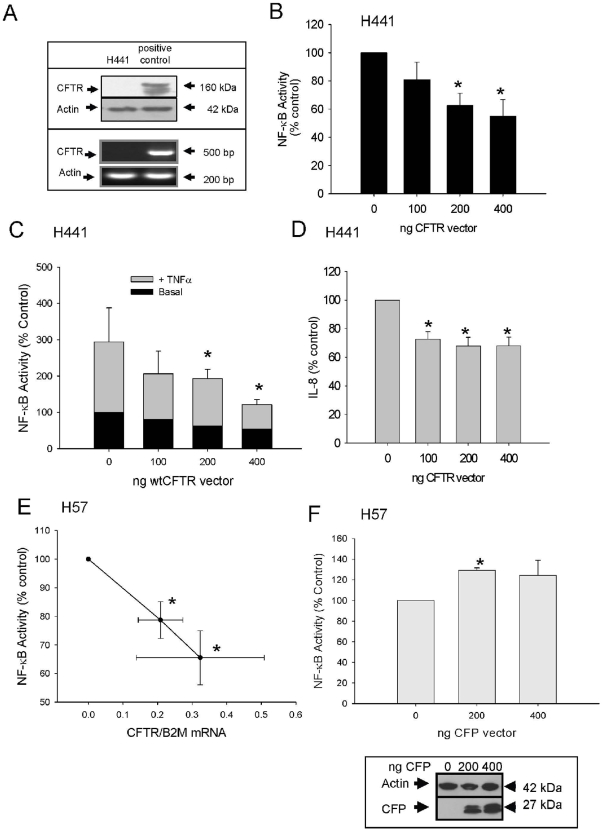
Wild-type CFTR attenuates both basal and induced inflammation.
A. H441 cells do not express CFTR protein as shown by western blot or CFTR mRNA as shown by RT-PCR (representative of 3 experiments). B. NF-κB activity in H441 cells transfected with increasing amounts of wt CFTR cDNA (0–400 ng, n = 5, *p<0.01). C. NF-κB activity in H441 cells transfected with increasing amounts of wt CFTR and treated with 10ng TNFα for 4 hours (open bars, n = 5, * p<0.001). Closed bars represent basal levels of activity re-drawn from figure 1B. D. The levels of IL-8 in the supernatants from B were measured by the ELISA method, n = 3, * p<0.01. E NF-κB activity (y-axis) in H57 cells transfected with increasing amounts of wt CFTR cDNA (0–400 ng), n = 5, *p<0.05. The amount of CFTR mRNA was then analysed by real-time PCR (qPCR) (x axis). There was no CFTR mRNA detected in the H57 cells prior to transfection, thus these treatments were allocated the nominal value of zero in all cases. F NF-κB activity in HeLa H57 cells transfected with increasing amounts of CFP vector (0–400 ng) n = 4, *p<0.05. Inset shows CFP levels following transfection with CFP vector.